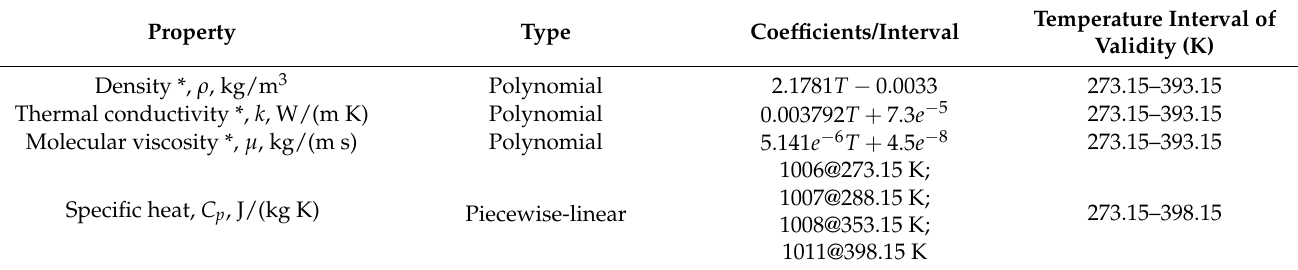
Table 3. Thermal properties of